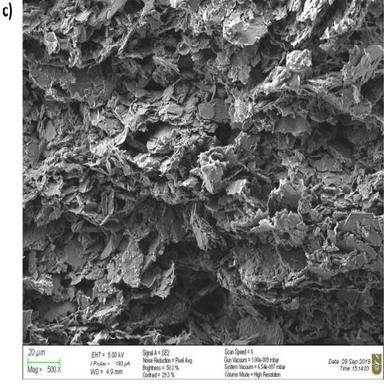
grayscale image of SEM micrographs a) Sample 1; b) Sample 2; c) Sample 3.